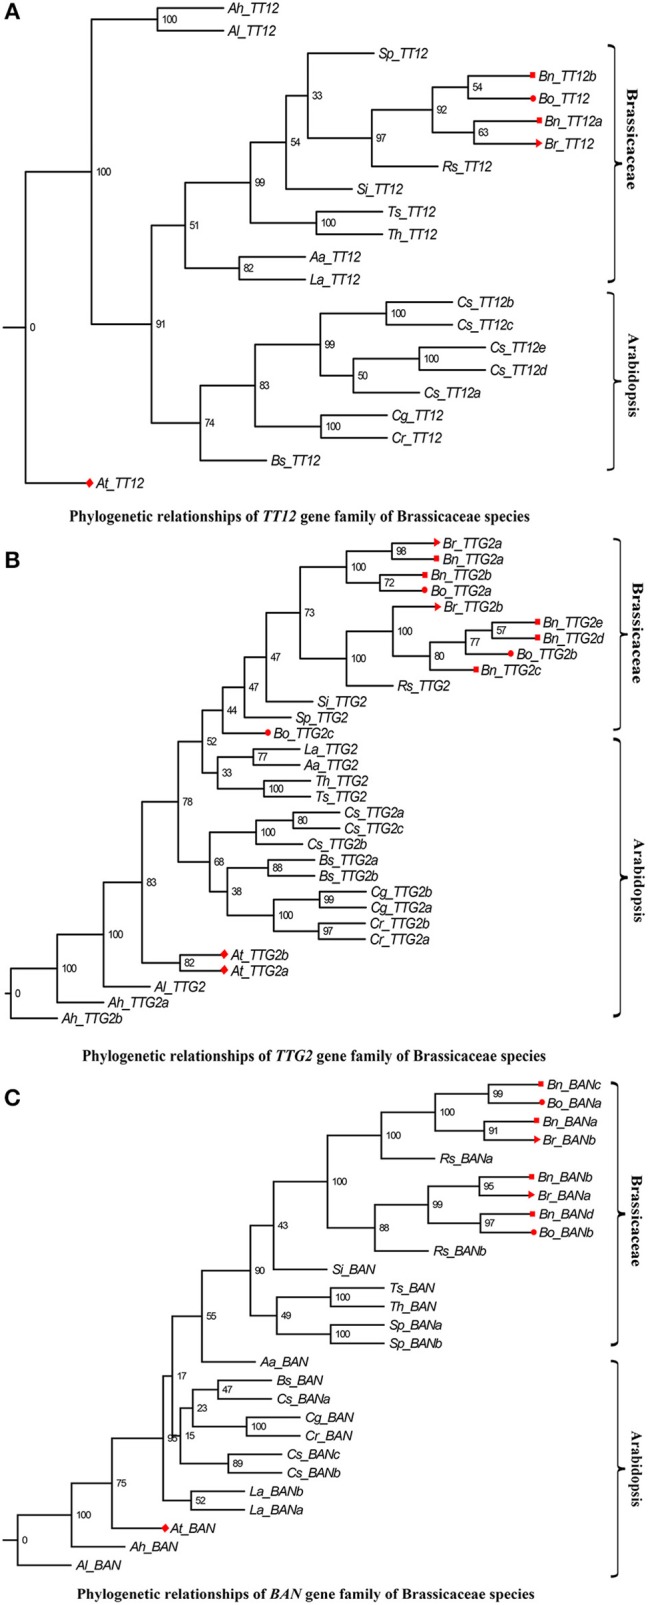
Phylogenetic relationships of TT12, TTG2, and BAN gene family of Brassicaceae species. The Red color diamond, triangle, circle, and rectangle were denoted the gene copies in A. thaliana, B. rapa, B. oleracea, and B. napus, respectively. Scale bar (the numbers) indicates the estimated number of amino acid substitutions per site. (A–C) were indicated TT12, TTG2, and BAN gene family, respectively.